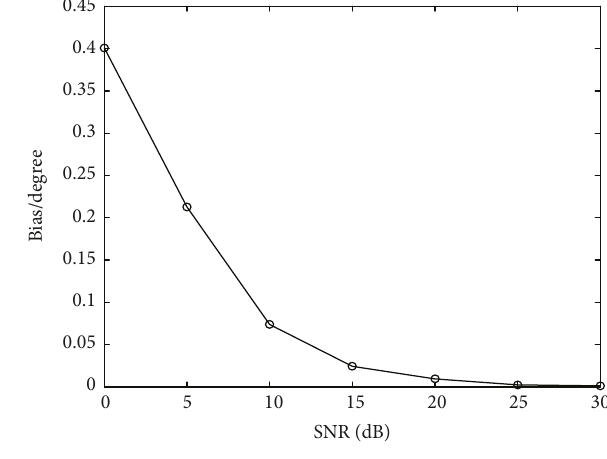
Figure 5: Bias of the estimator versus SNR. Figure 3: Angle estimation result of close sources for 30